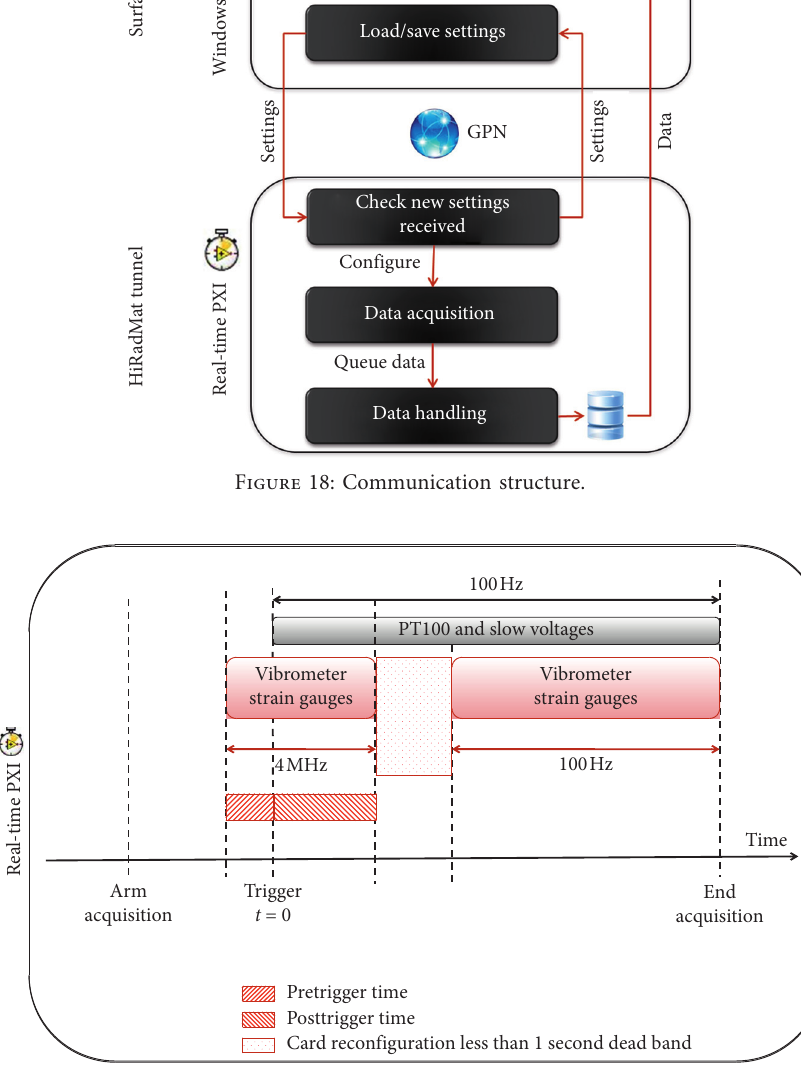
Figure 19: Data acquisition scheme.